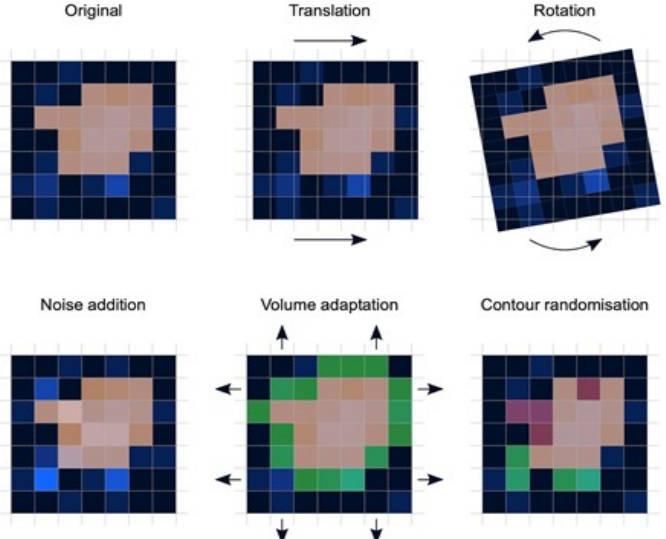
Figure 2. Variations in patient positioning, image acquisition, and segmentation affect each feature to varying degrees. If radiomic models use features that are not robust against such influences, they will perform poorly when applied to new data. Assessing feature robustness is thus recommended to improve the generalizability of radiomic models and feature analysis.